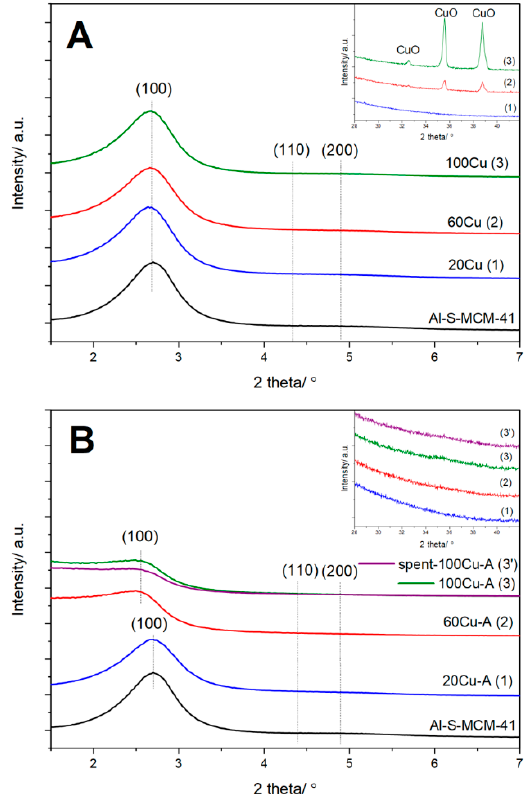
Figure 1. Powder X-ray diffractograms of the Al-S-MCM-41 sample and its modifications with copper obtained by TIE ( A ) and TIE-NH 3 ( B ) methods.